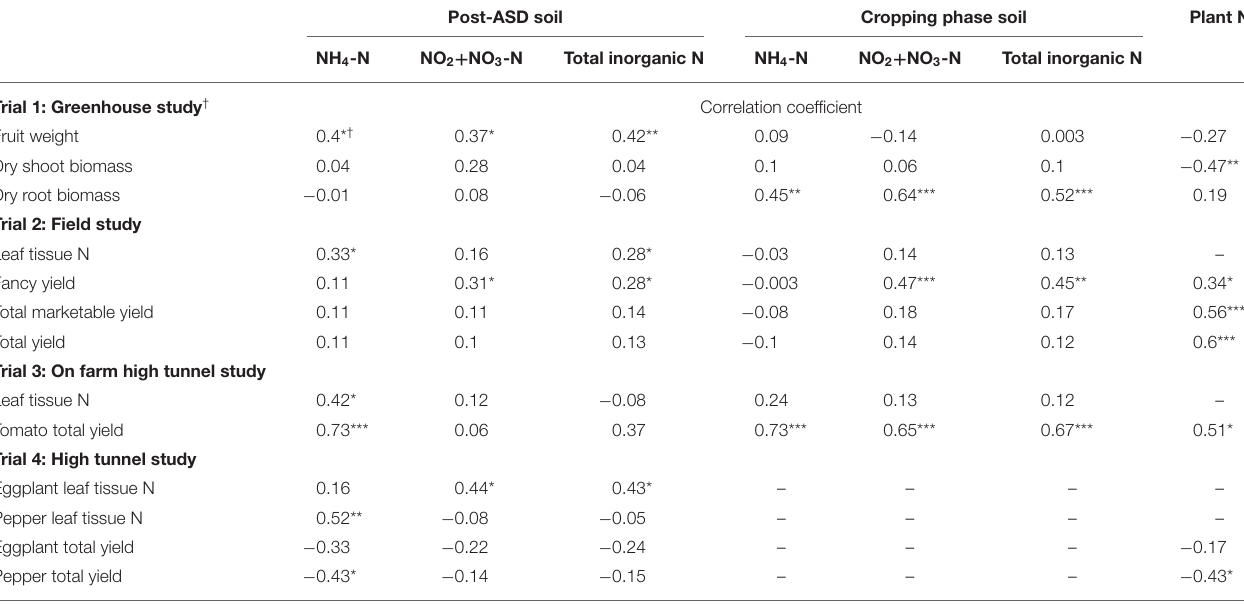
TABLE 4 | Correlation analysis of crop performance variables and soil and leaf tissue N in each trial.